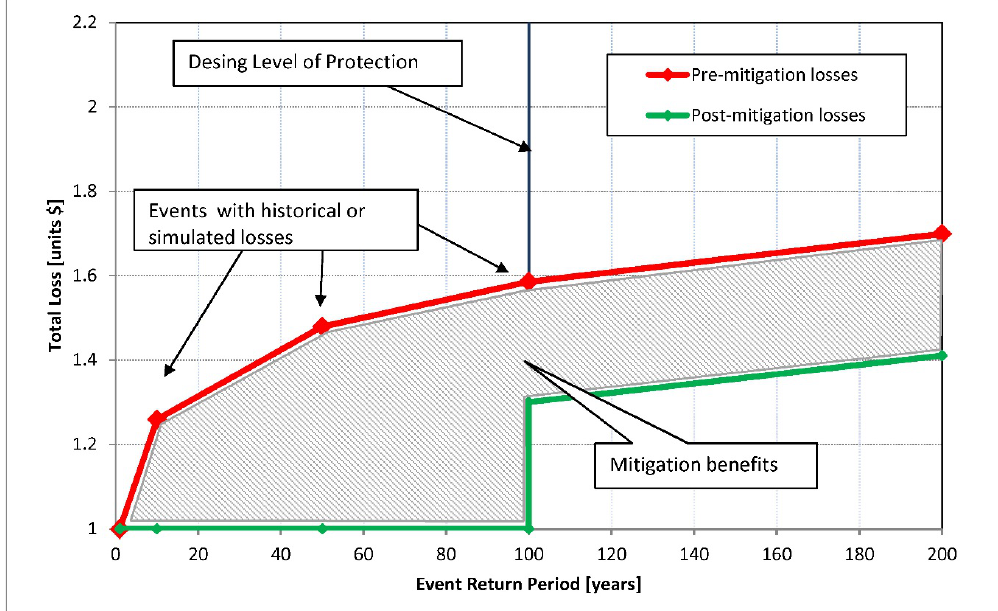
Figure 4. Illustration of the concept of mitigation benefits, defined as an integrated area of difference between two sets of damage curves, for pre-mitigation and post-mitigation conditions. Note the assumption of zero residual losses, up to the design level of protection. The magnitude of flooding events is in correlation with their return periods. All numeric values are arbitrary and for illustration